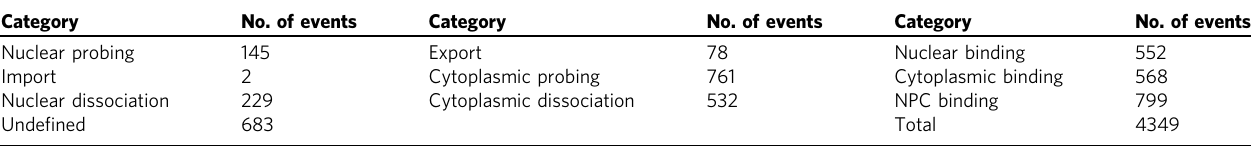
Table 1 Number of detected interaction events with single NPCs sorted according to the type of interaction.